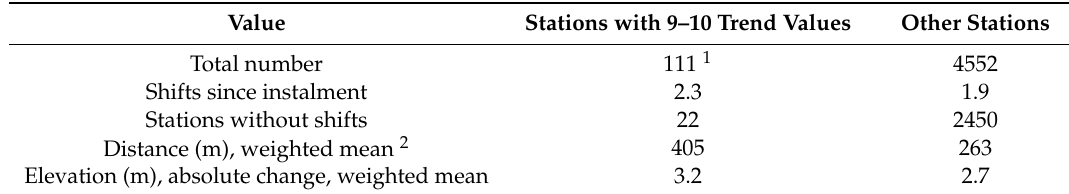
Table 1. Summary of stations with calculated trend